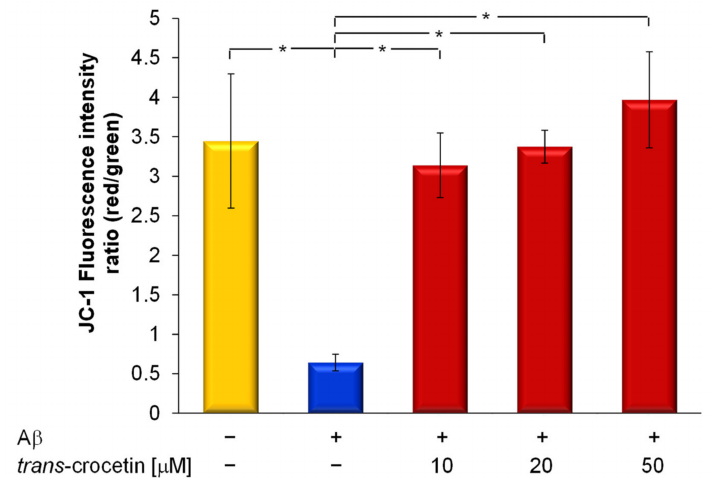
Figure 4. Trans-crocetin inhibited A β -induced depolarization. Mitochondrial membrane potential was detected by the ratio between JC-1 red and green fluorescence intensity. The values, expressed as average ± SD, are the means of three experiments, and statistically significant data were evaluated according to an ANOVA followed by a Bonferroni t -test ( p < 0.05). * vs. A β